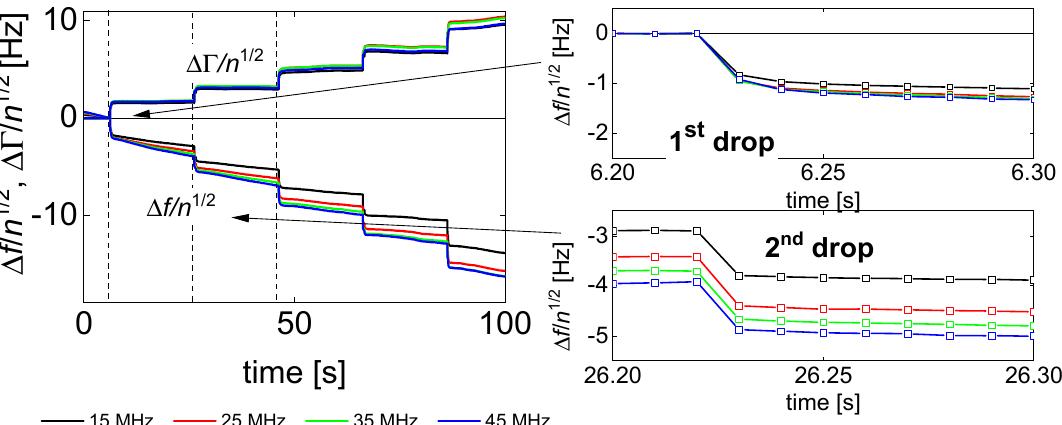
Figure 6. ( Left ) Raw data from an experiment with Food Black 2 in the liquid 30:30:40 (concentration: 10 wt%), where 10 droplets were deposited at separate spots. Only 5 events are shown for clarity. Data have been normalized to n 1/2 because this lets the data from the different overtones overlap. ( Right ) Impact no 2 shifts Δ f slightly less than the previous impact no 1.